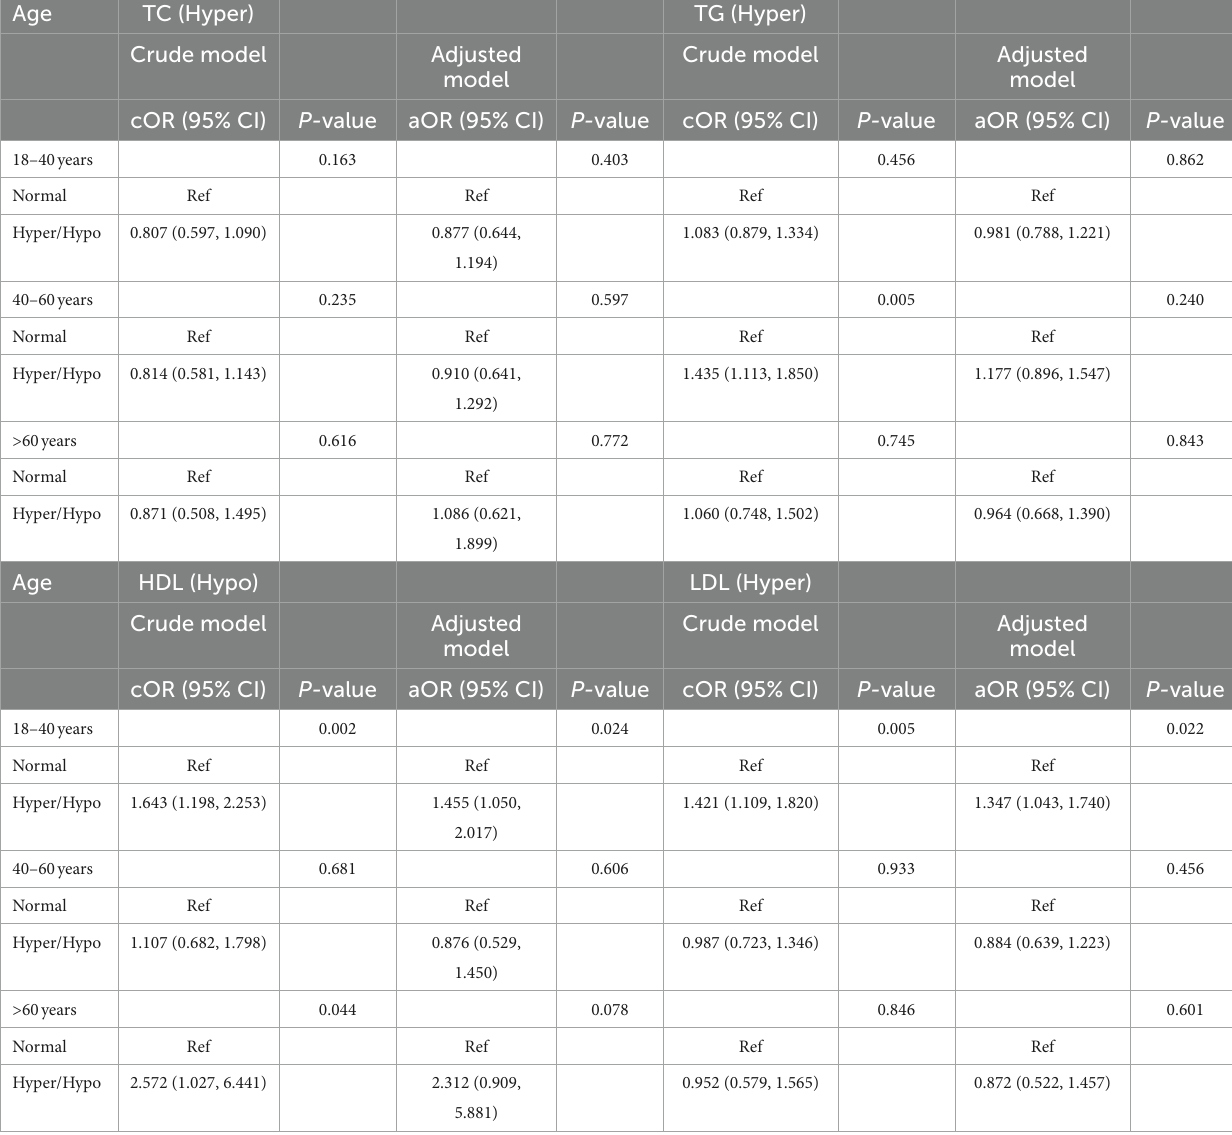
TABLE 3 Odds ratios for associations between triglyceride and cholesterol levels and anti-HBs results stratified by